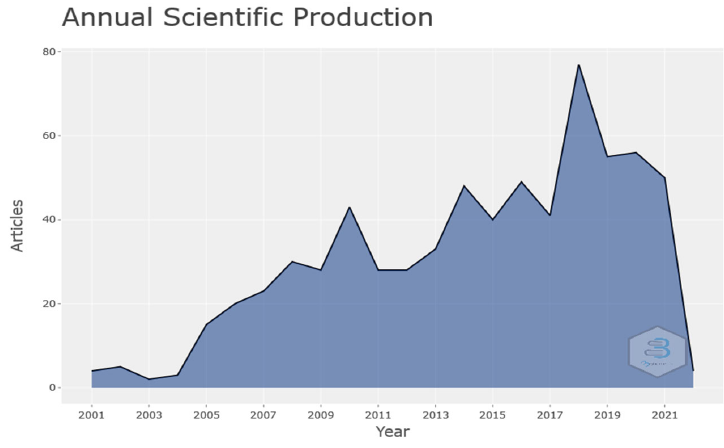
Fig. 1. Published Papers